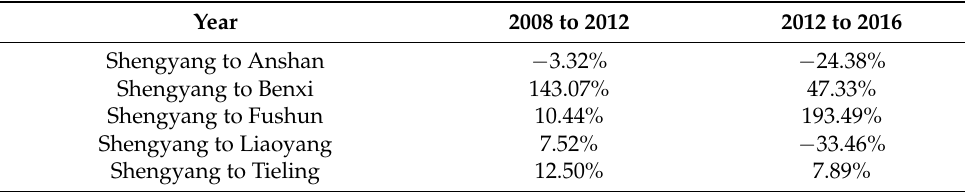
Table 7. Urban gravity change rate of central Liaoning urban